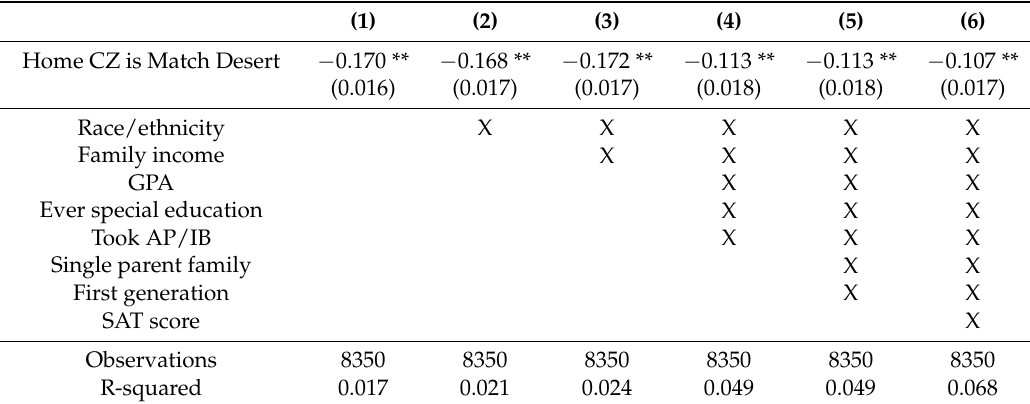
Table 8. Relationship between living in match desert and enrolling in a strict academic-match